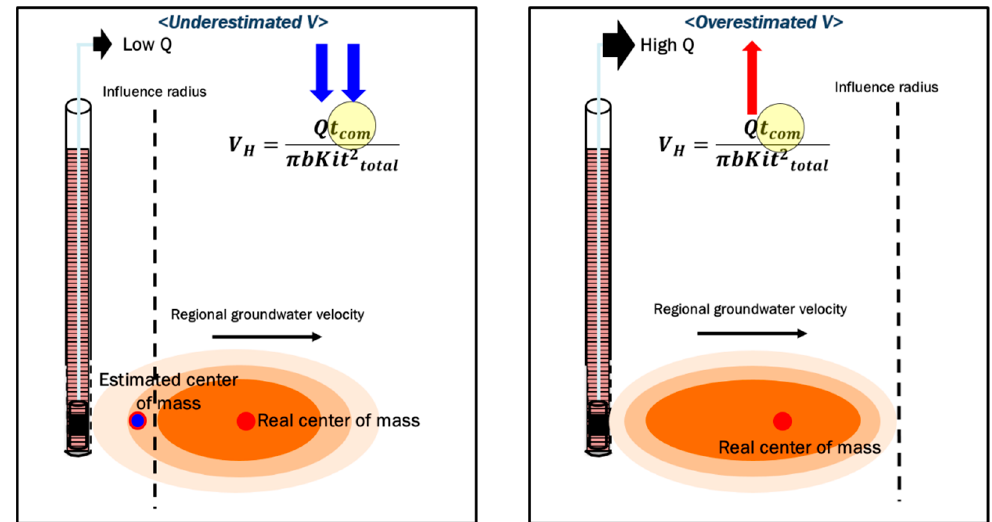
Figure 9 . Numerical simulation results in the no-density effect condition (case ( A ), 160 mg/L) and the density-effect condition (case ( B ), 500 mg/L) at three time points (t = 3103 s: the end of the injection phase, t = 3703 s: the end of the drift phase, and t = 13,320 s: the end of the pumping phase) with different pumping rates.